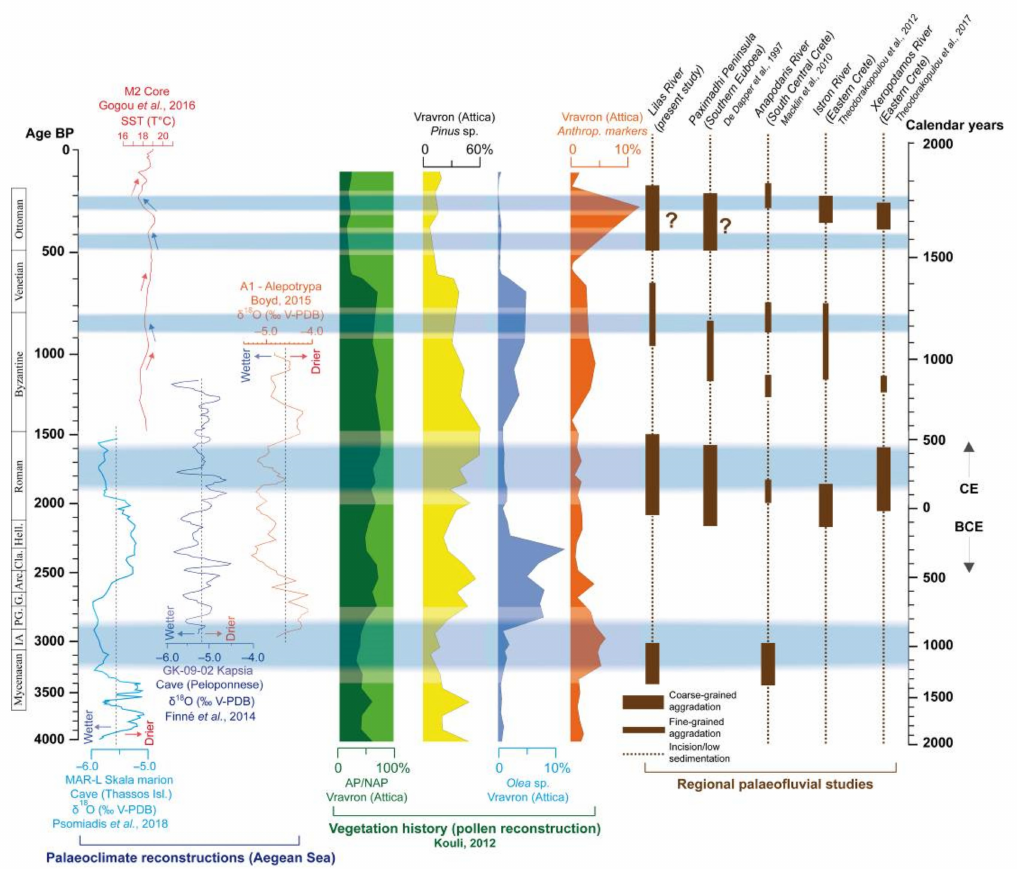
Figure 12. Palaeoclimatic reconstructions obtained for the Aegean Sea and Peloponnese (see Figure 1 for location of the different sites) vs. pollen results derived from the Vravron sequence (Figure 1 [72]) and palaeofluvial reconstructions obtained for islands of Euboea [24] and Crete [19–21]. Blue lines indicate wet episodes